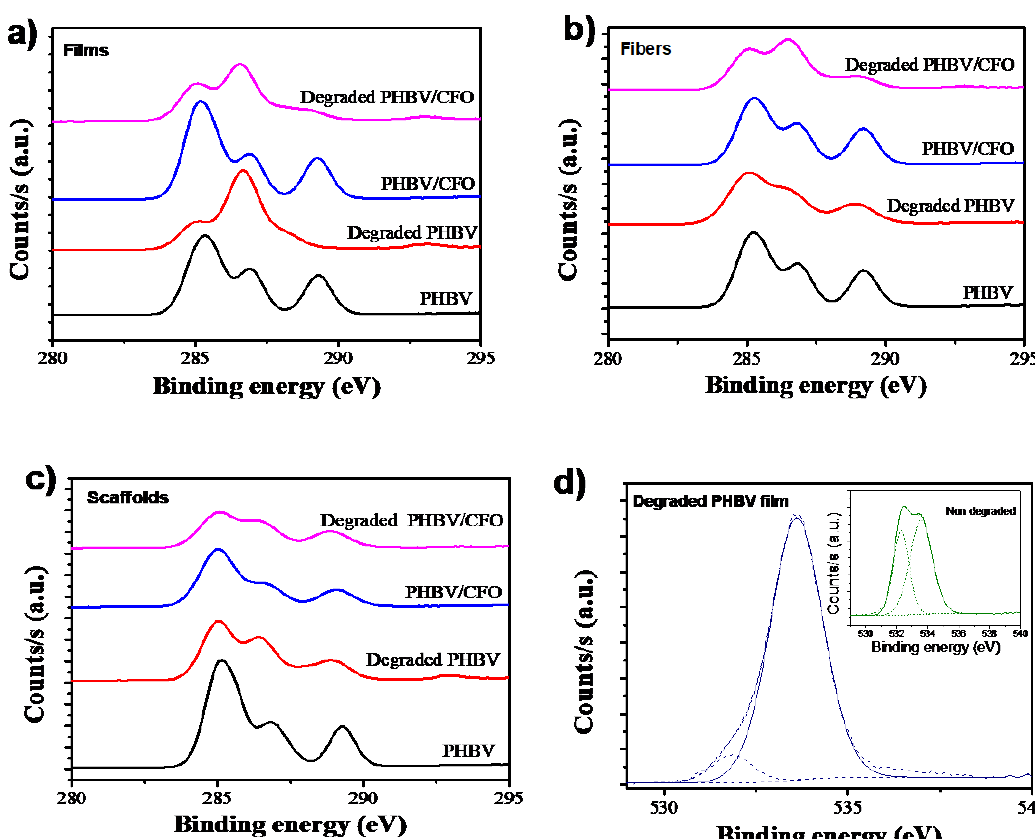
Figure 5. XPS results of non-degraded and degraded PHBV and PHBV / CFO samples with di ff erent morphologies: ( a – c ) C1s scan spectra for films, fibers and sca ff olds, respectively and ( d ) O1s spectra. Table 2. Surface chemical composition of non-degraded and degraded PHBV and PHBV/CFO samples.